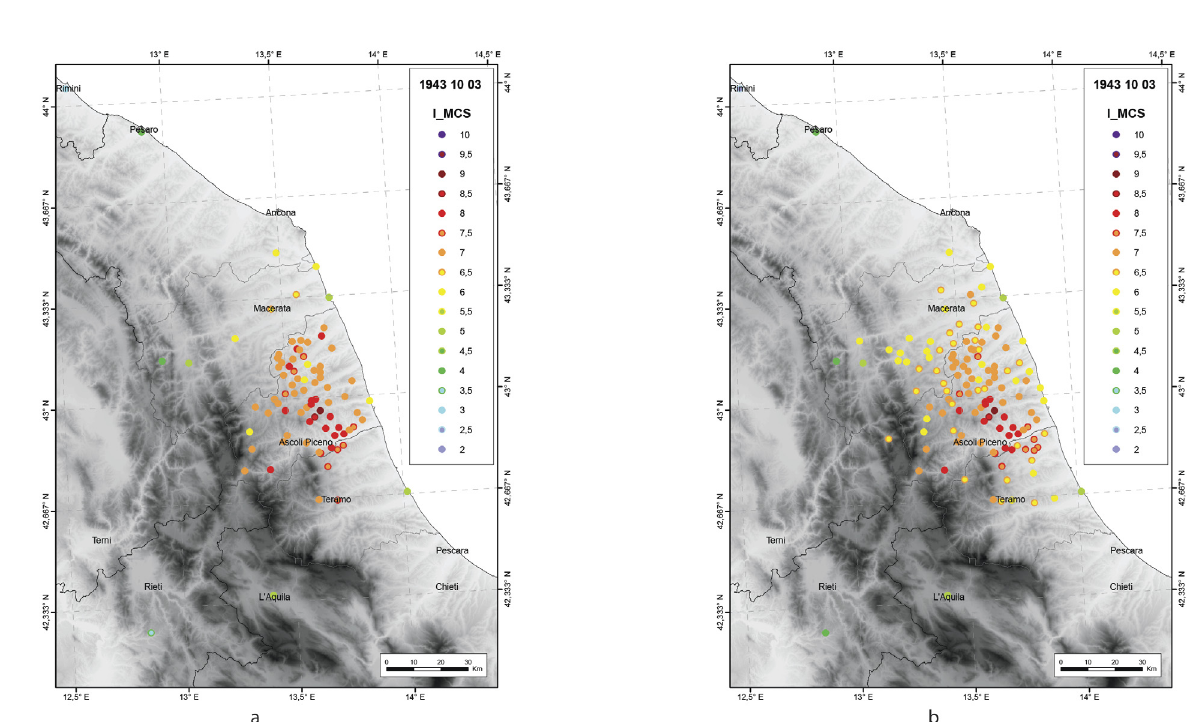
Figure 3. Intensity map of the October 3, 1943 earthquake after a) Raccichini et al., 1985; b) Guidoboni et al. [2007]. The provincial borders drawn in figure are those currently effective in